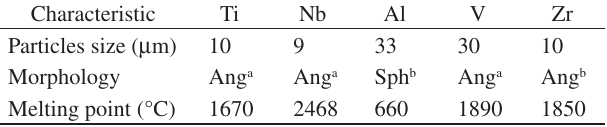
Table 1. Characteristics of the powders used in the alloys preparation. Characteristic